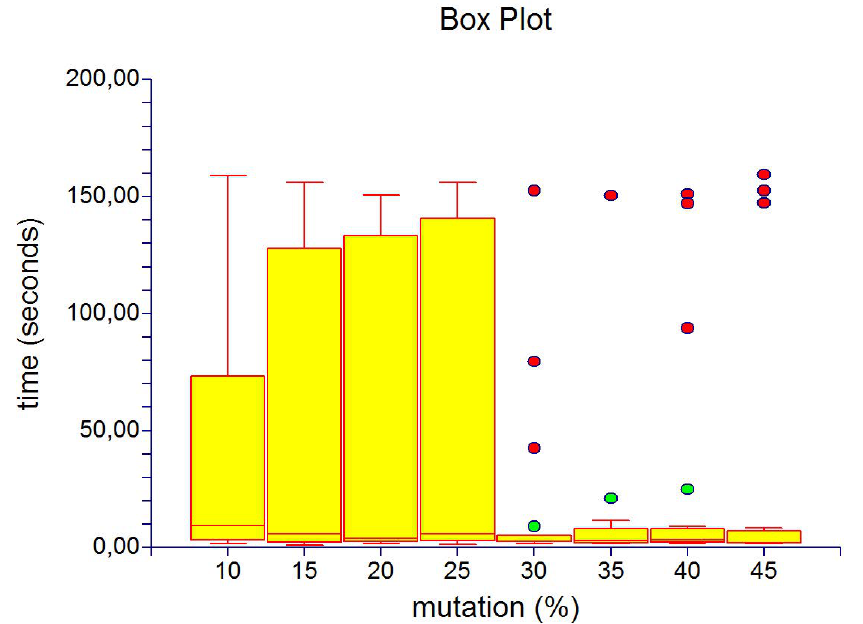
Figure 8. Exp. no. 1—Box